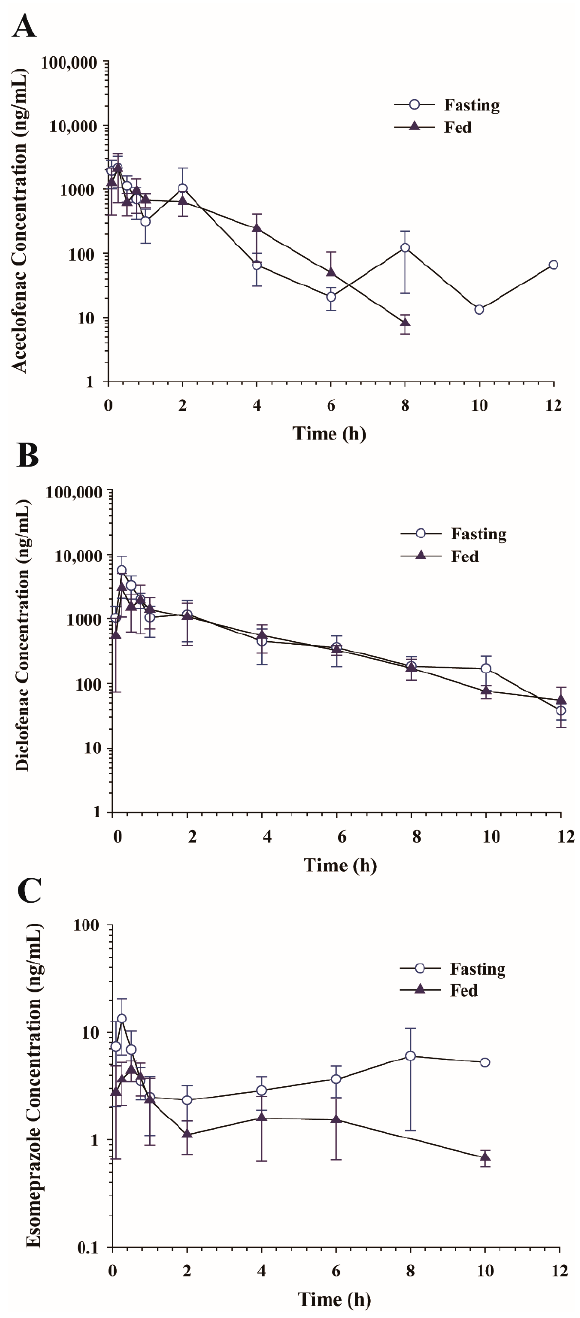
Figure 4. Average plasma concentration-time profiles of ( A ) aceclofenac, ( B ) diclofenac, and ( C ) esomeprazole following oral administration of aceclofenac (20 mg/kg) in combination with esomeprazole (4 mg/kg) in rats with fasting vs. fed conditions. Data represent mean ± SD ( n = 4–5).